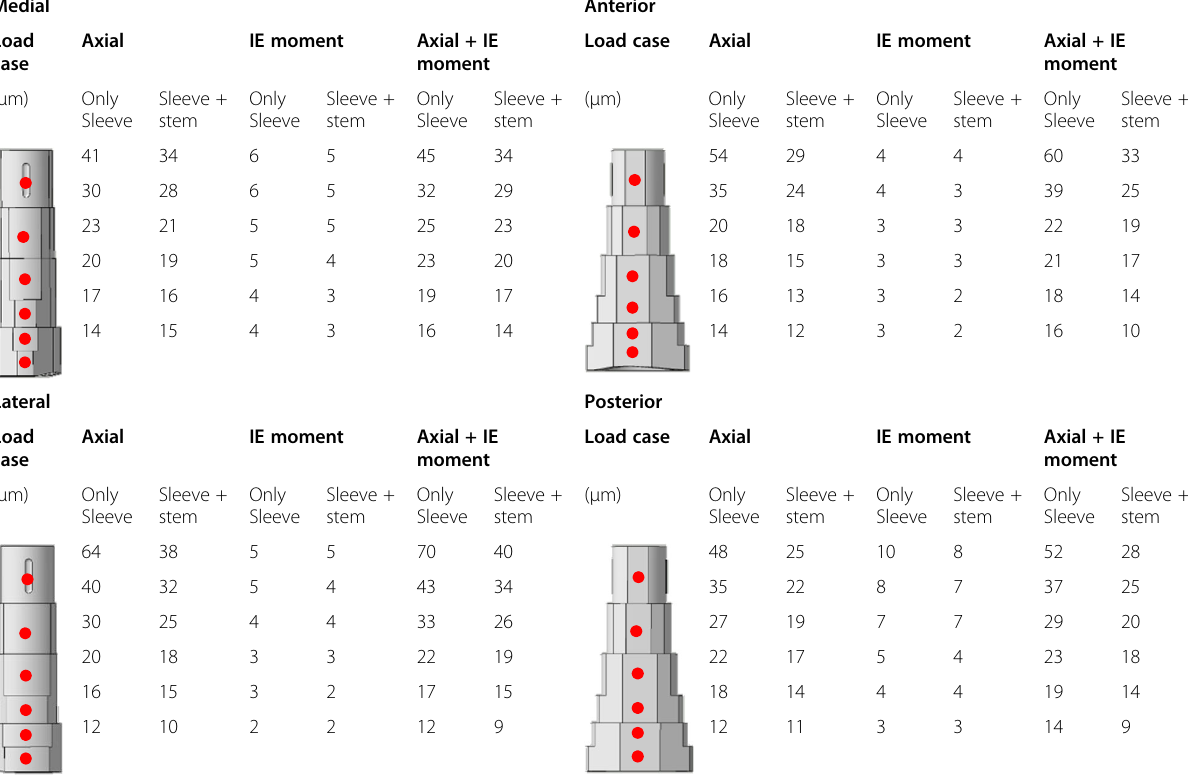
Table 3 Interface micromotions ( μ m) between sleeve and cancellous-bone along medial, anterior, lateral and posterior sides Medial